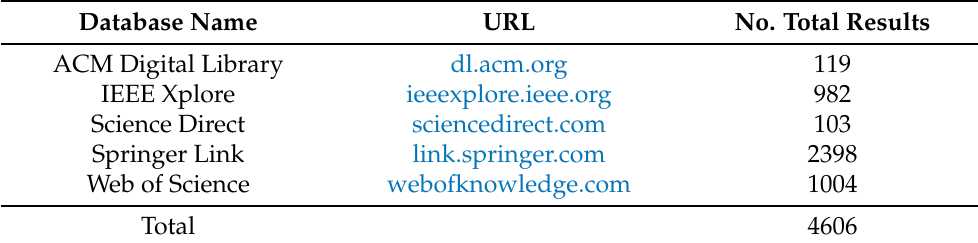
Table 1. Databases with the total number of search results.